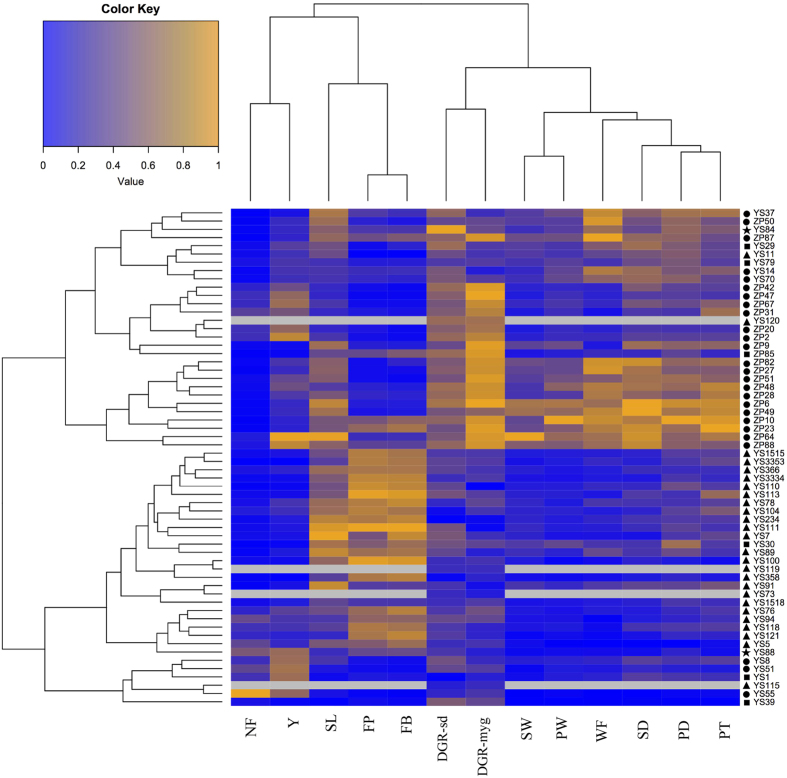
Phenotypic variation of all 60 shiitake strains.The strains are shown in rows and phenotypes in columns. The abbreviation of each phenotype is shown at the bottom: FP, the time interval (in days) from incubation to formation of the first primordium (d); FB, the time interval (in days) from incubation to harvest of the first fruiting body (d); PD, pileus diameter (mm); PT, pileus thickness (mm); PW, pileus weight (g); SL, stipe length (mm); SD, stipe diameter (mm); SW, stipe weight (g); NF, number of fruiting bodies (per/bag); WF, weight of a single fruiting body (g); Y, total weight of fruiting bodies per bag (g/bag); DGR-myg, mycelium growth rate on MYG medium; DGR-sd, mycelium growth rate on sawdust medium. Phenotype values were normalized according to the color key at the top left corner; missing data are shown in gray shading. Clustering of phenotypes and strains were performed by the complete linkage method with Euclidean distances. The grouping of strains as identified in the phylogenetic analysis are marked in different symbols: ●, Group I; ■, Group II; ▲, Group III; ★, outlier strains.